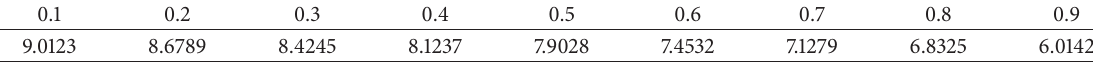
Table 4: Maximum allowable time delay bounds ℎ for different values ℎ 𝐷 in Example 3.